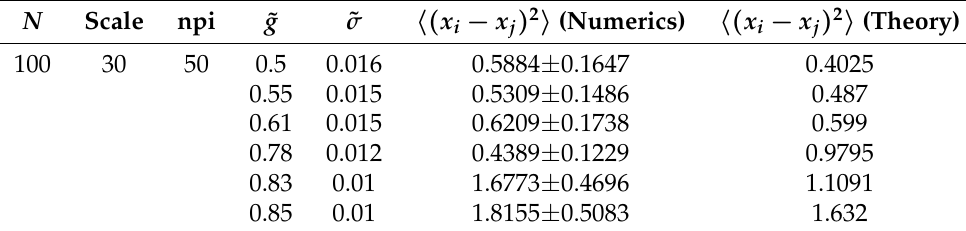
Table 1. Quantum fluctuations of the relative velocity of constituent solitons obtained from numerical calculations and from theory. N is the number of atoms, “scale” represents with t being the simulation time, “npi” stays for the number of trajectories, ˜ g and ˜ σ denote the dimensionless forms of the interaction strength and the width of the Gaussian potential, respectively. See text for